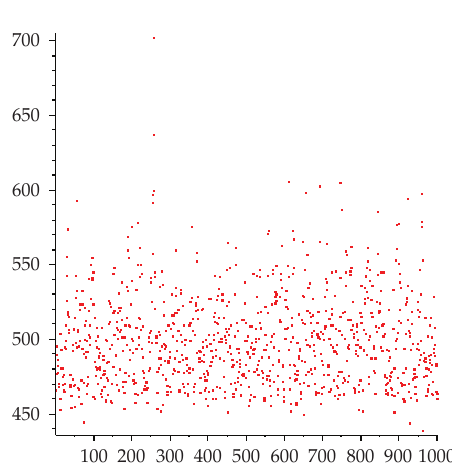
Figure 12: (cid:2) t,y (cid:2) t (cid:3)(cid:3) in the stochastic case for d (cid:7) 0 . 8.